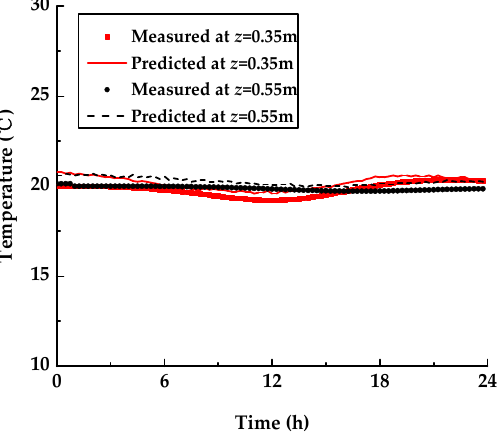
Figure 10. Measured and predicted temperature at z = 0.35 m and z = 0.55 m on 16 December.